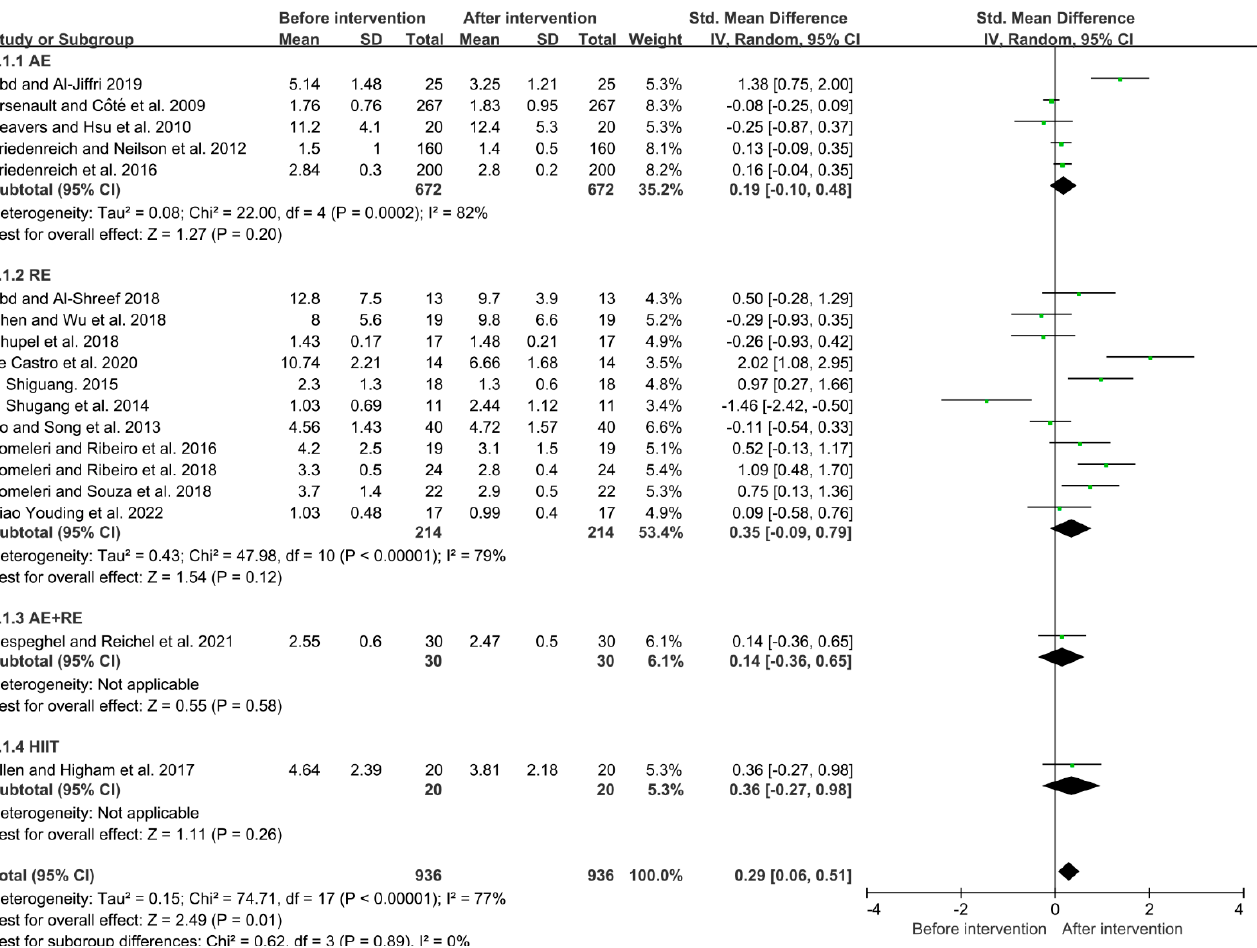
α in the elderly [7,14,16,17,21,23,24,26,28,30–